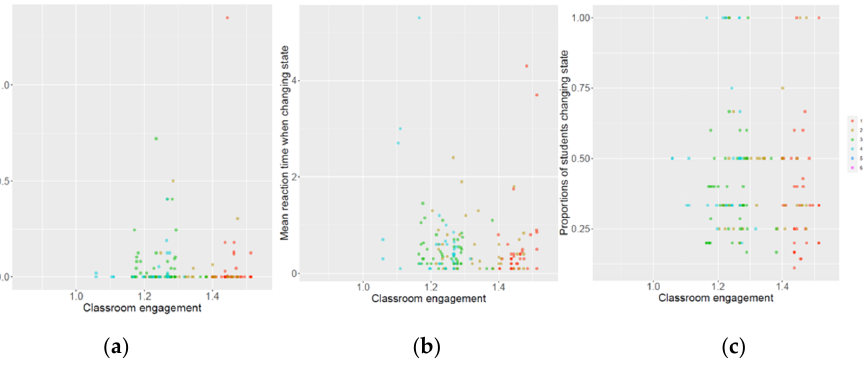
Figure 7. Reaction times as a function of the classroom engagement: ( a ) the variance in reaction time; ( b ) the mean reaction time and ( c ) the proportion of students changing state. The colours refer to the different lectures.